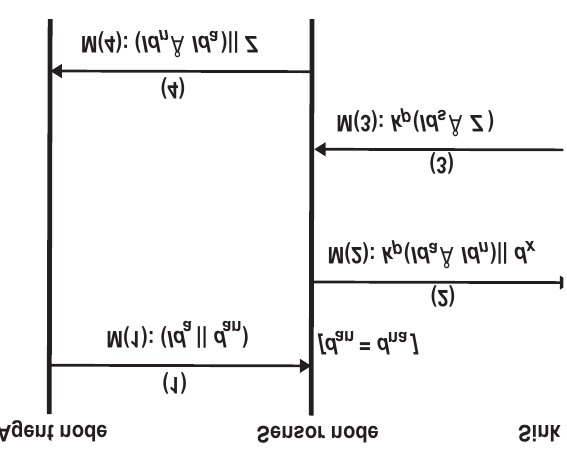
Figure 4. Two-way authentication scheme